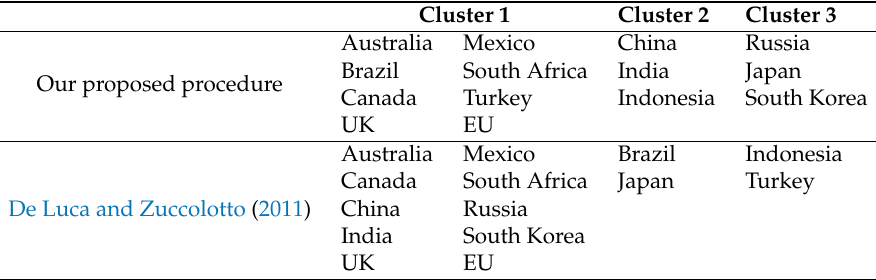
Table 6. Members for each of the clusters when k = 3.